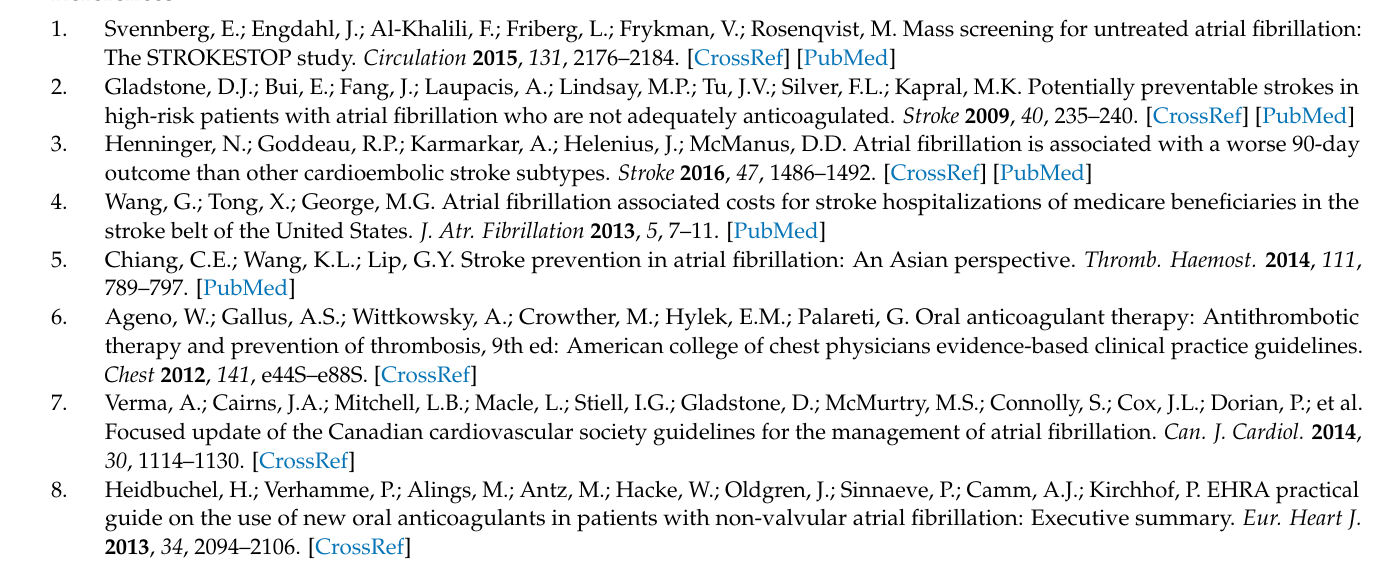
hazard ratio on age, Figure S2: Regression of log hazard ratio on female ratio, Figure S3: Regression of log hazard ratio on publication year, Figure S4: Major GIB subanalysis, Figure S5: GIB meta-analysis of different NOACs doses versus